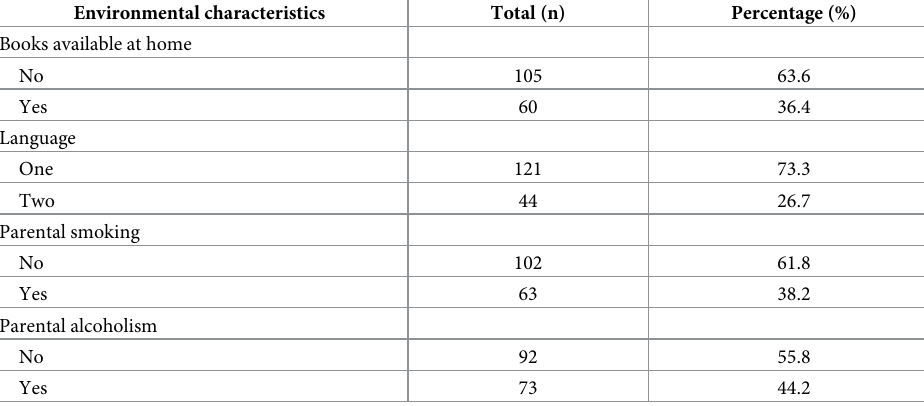
Table 3. Environmental